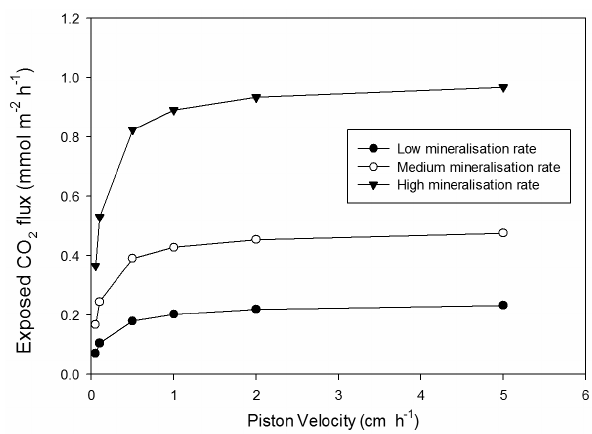
Fig. 6. Exposed flux of CO 2 with varying piston velocity and respi- ration rate. Low, medium and high mineralisation rates refer to peak DIC productions of approx. 600, 1300 and 2600µmolm − 2 h − 1 , re-